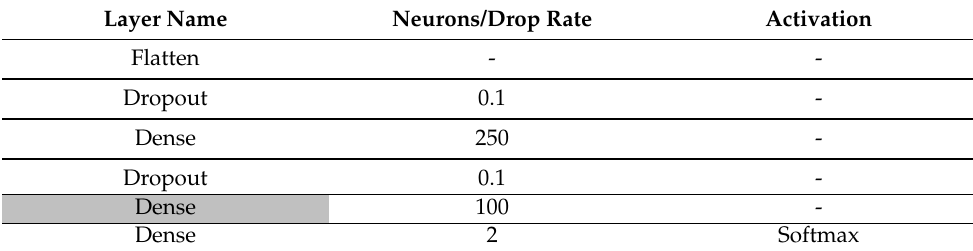
Table 2. MLP architecture.